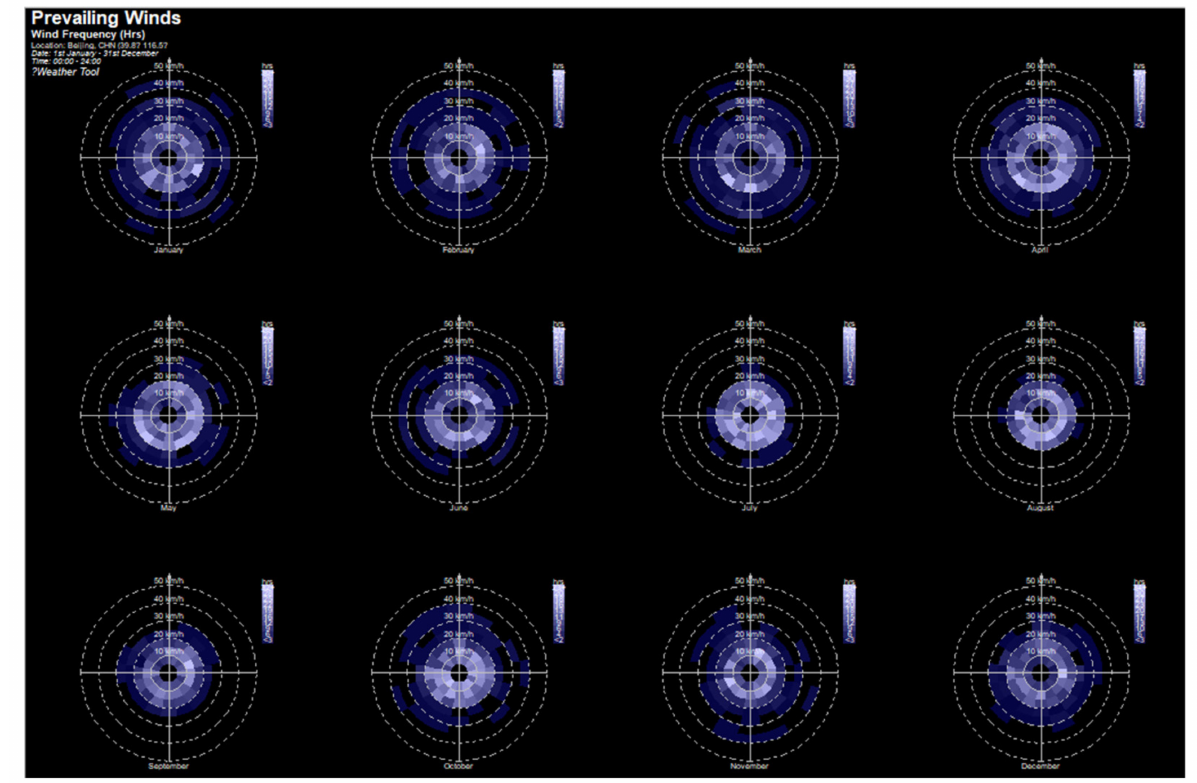
Figure 22. Annual wind frequency chart.